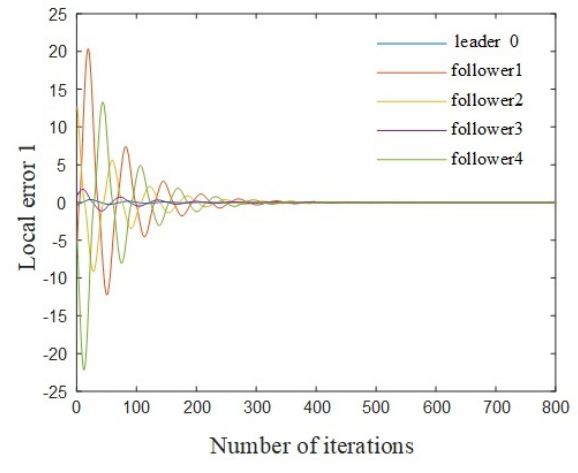
Fig. 4. The local error ε i 2 ( k ) in (2).